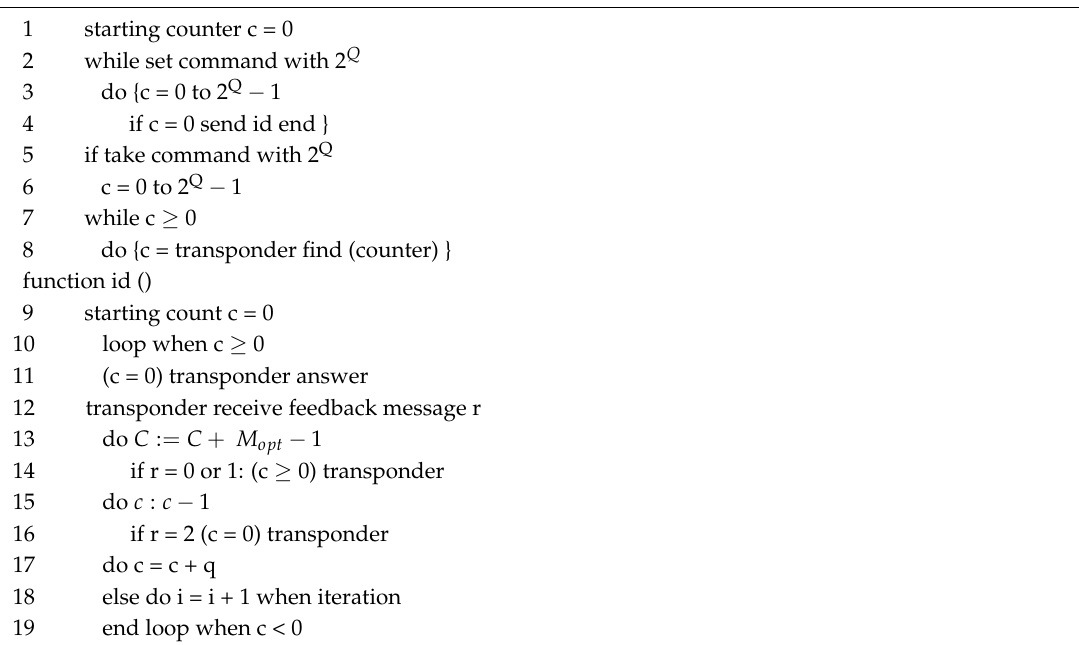
Algorithm 2. Pseudo code of DFA-OS: tag